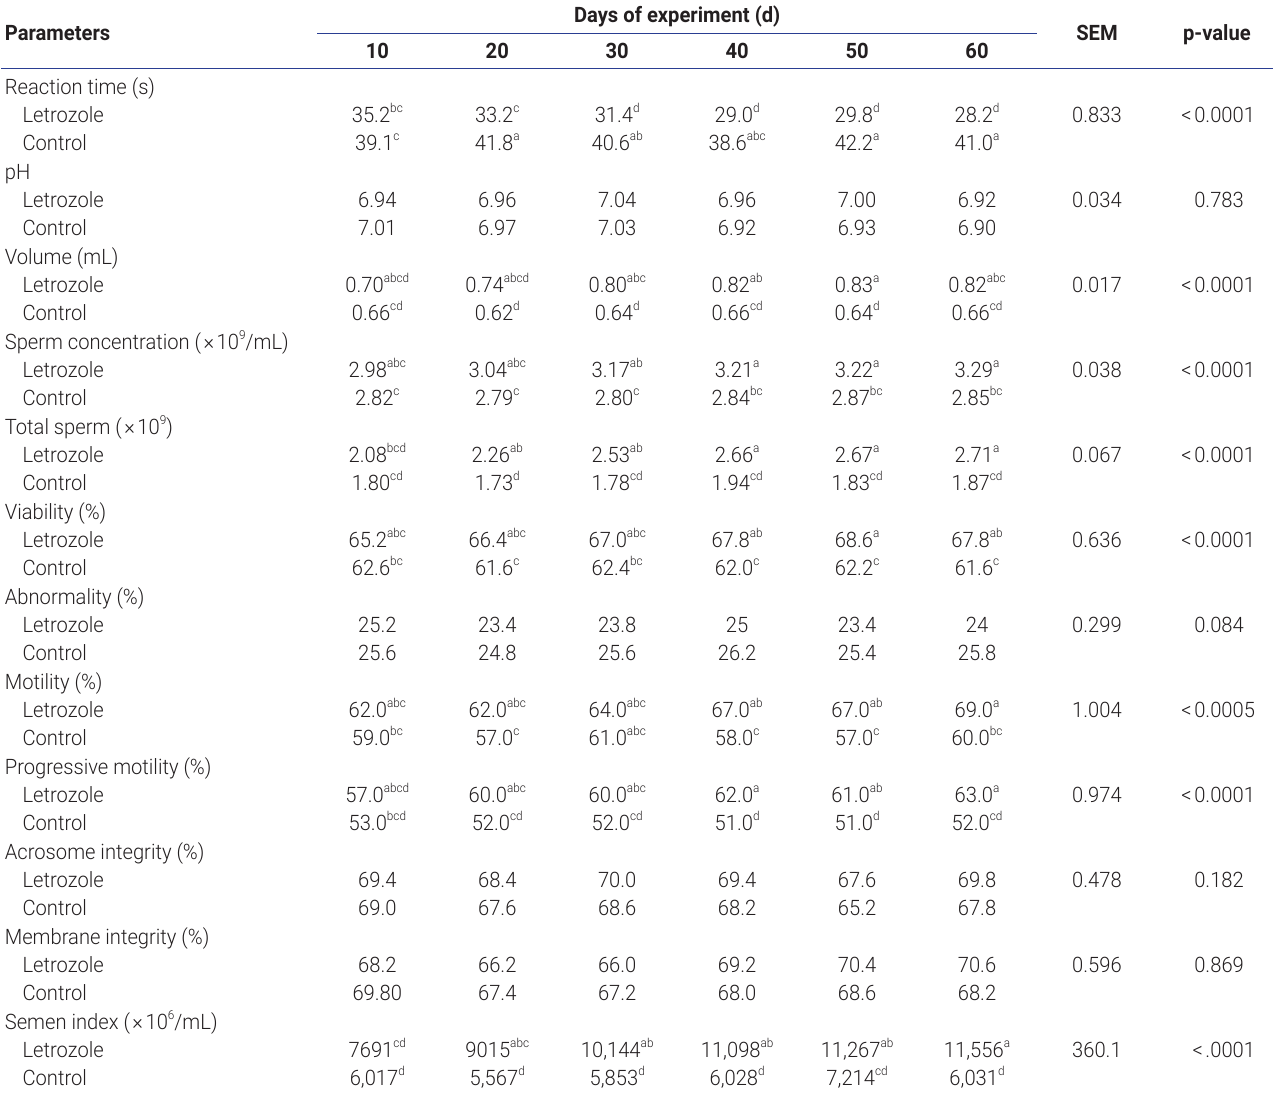
Table 2. Semen characteristics in Markhoz bucks treated letrozole (0.25 mg/kg BW/wk) or control